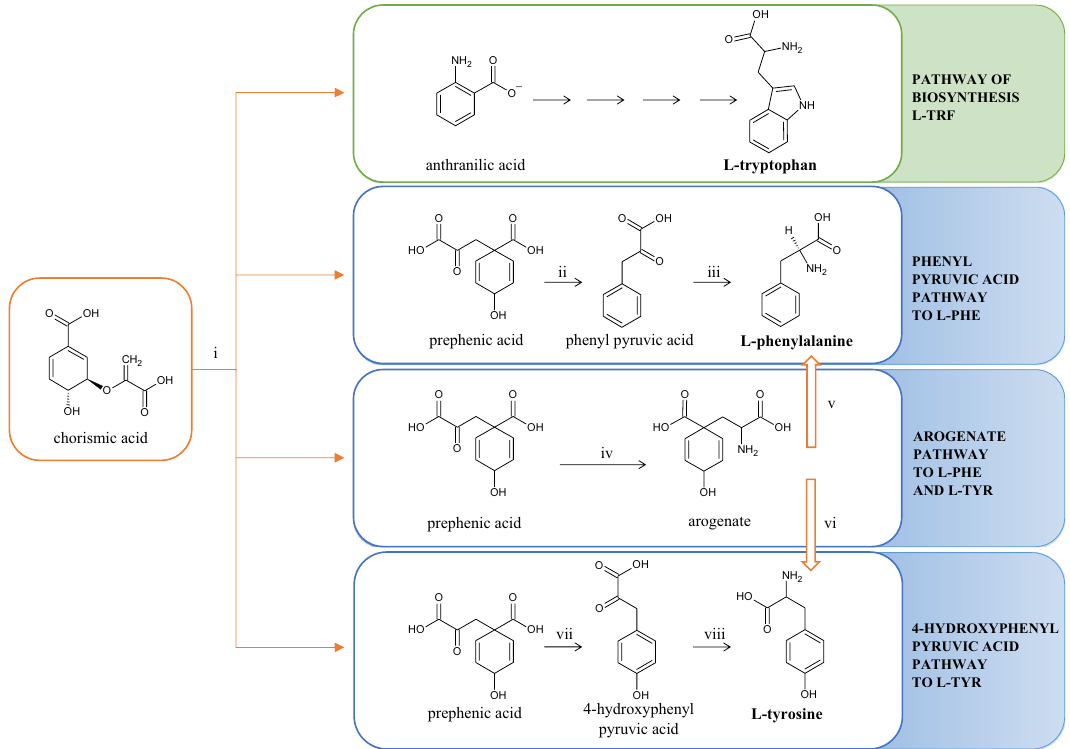
Figure 2. Biosynthesis of the aromatic amino acids tryptophan, tyrosine, and phenylalanine via a common pathway to chorismite in S. cerevisiae . i—chorismate mutase, ii—prephenate dehydratase, iii—transaminases, iv—transaminases, v—arogenate dehydratase, vi—arogenate dehydrogenase, vii—prephenate dehydrogenase,